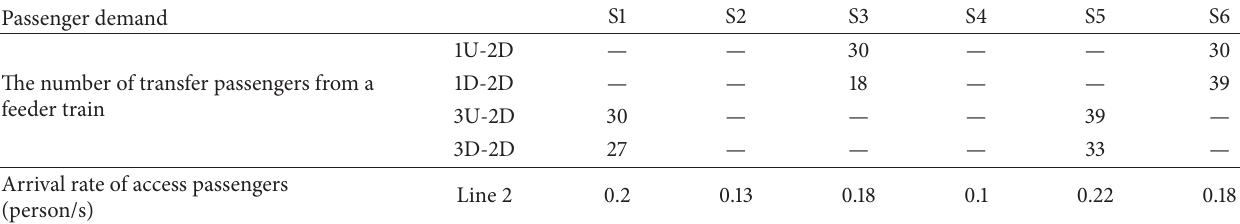
Table 3: Passenger demand.